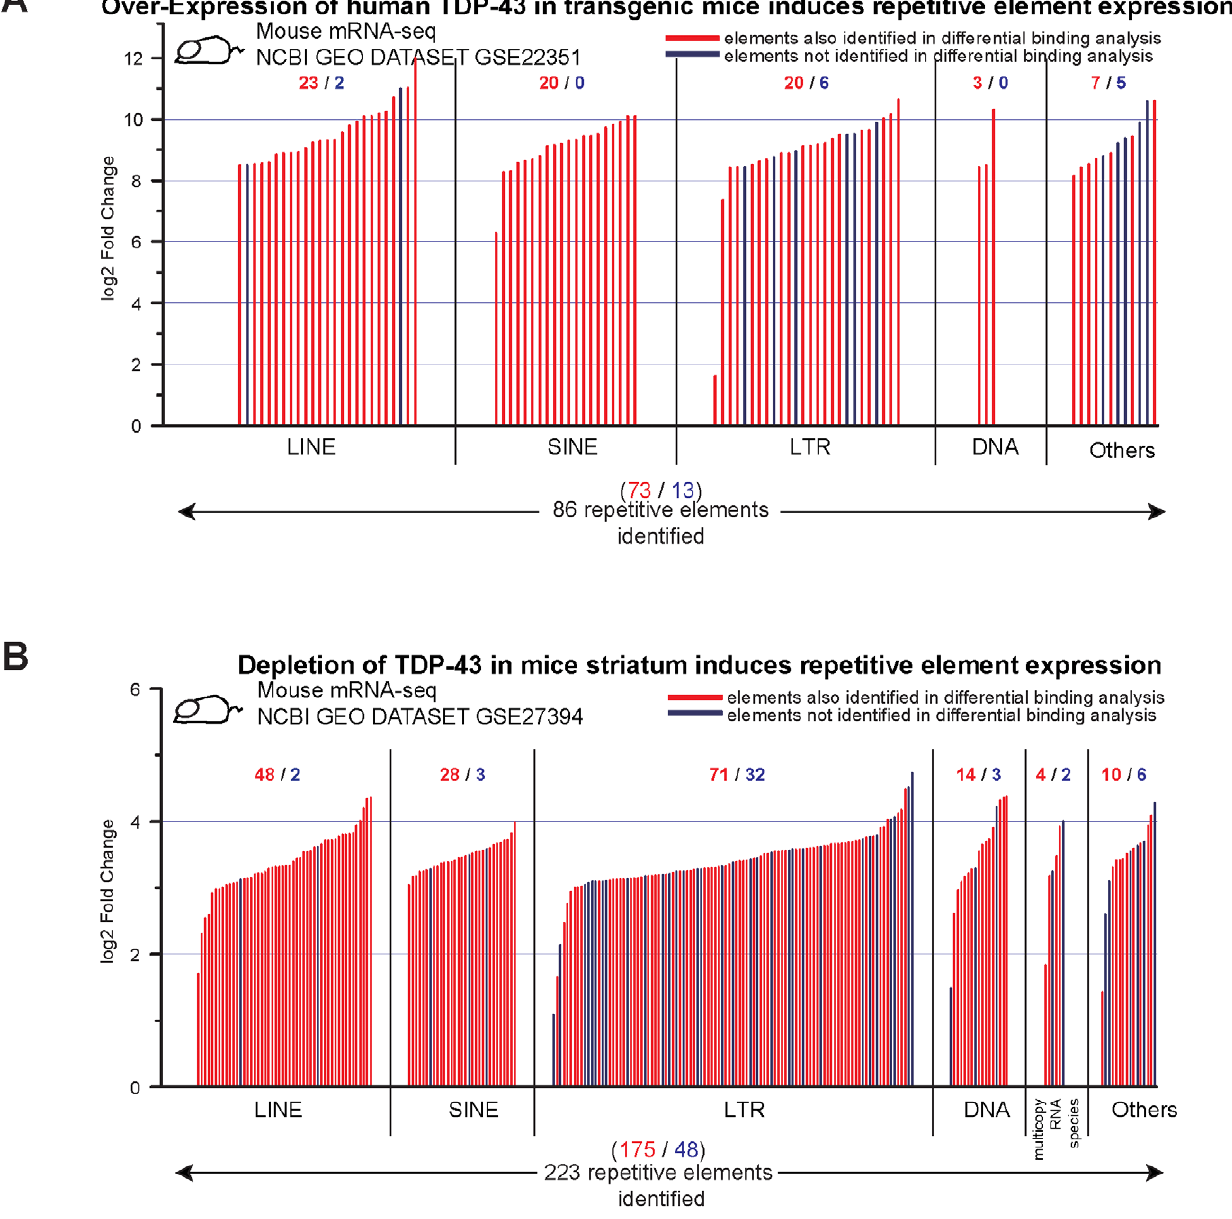
Figure 3. Concordance between mis-regulated TE transcripts upon TDP-43 manipulation and TDP-43 bound TE transcripts. (A,B) Over-expression [20] of TDP-43 in transgenic mice and depletion [19] of TDP-43 in mouse striatum each result in elevated expression of many TE derived transcripts. The majority of over-expressed TEs also were detected (Table S3) as binding targets by CLIP-seq (RED). A few showed elevated expression but were not detected as binding targets (BLUE).